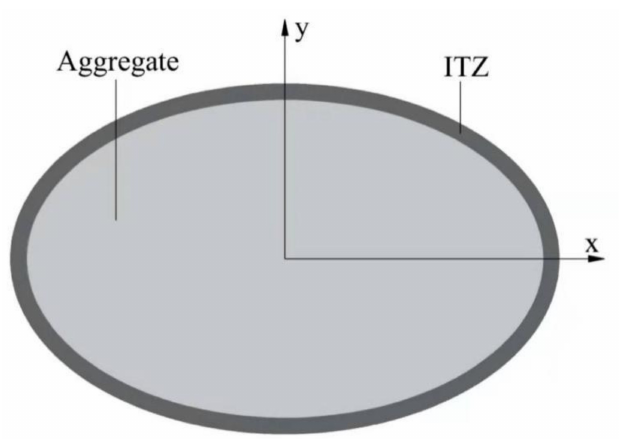
Figure 3. Equivalent elliptical aggregate coated with an equal thickness